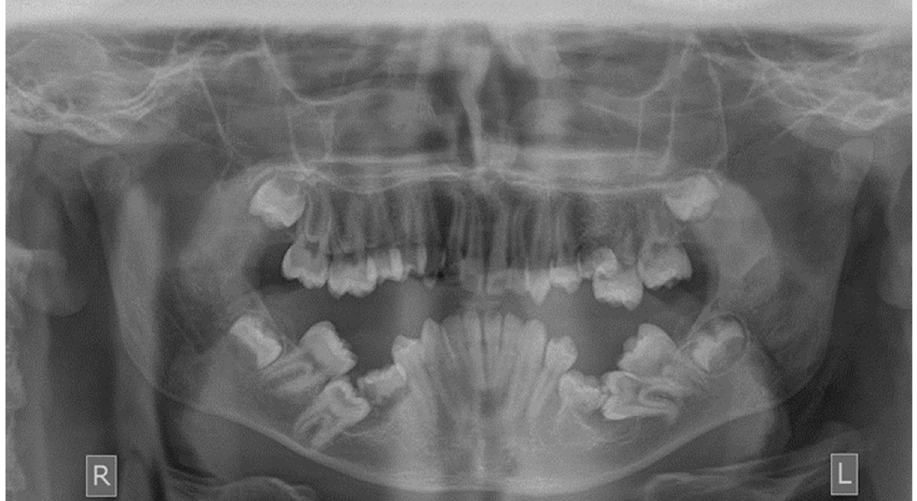
Figure 2. Impacted first mandibular molars.